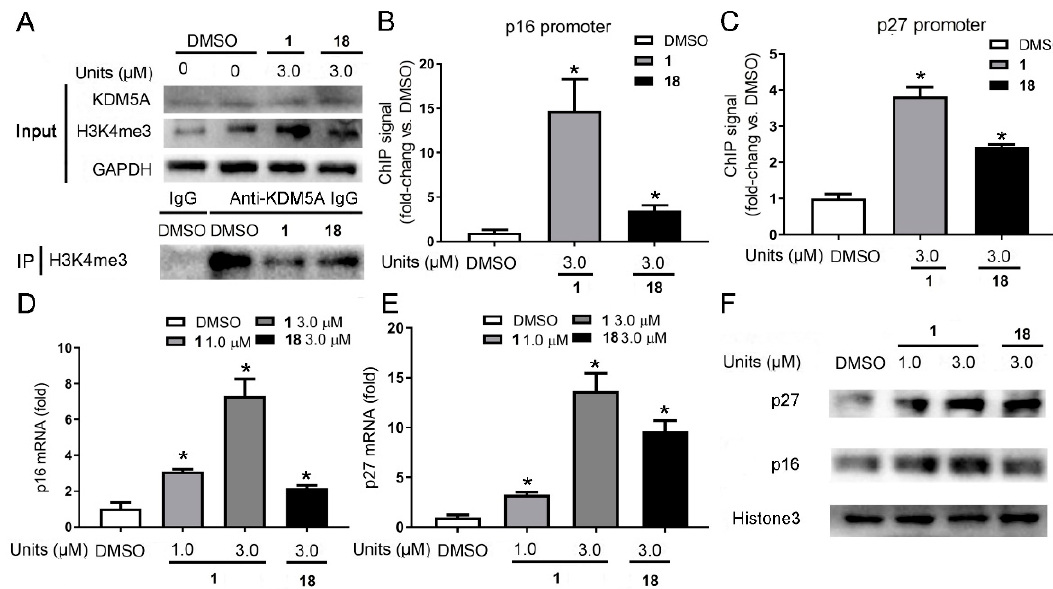
Figure 5. 1 and 18 promotes p16 and p27 production by blocking KDM5A-mediated H3K4me3 demethylation in MDA-MB-231 cells. Effect of 1 on the interactions KDM5A-H3K4me3 was examined by co-IP ( A ). Effect of 1 on H3K4me3 at promoters of p16 and p27 gene in MDA-MB-231 cells ( B , C ). ChIP assay was conducted with primary antibody against H3K4me3. transcriptional ( D , E ) and protein ( F ) levels of p21 and p27 in MDA-MB-231 cells treated with 1 or 18 were measured by Western blotting analysis. Bar graphs represented the mean enrichment relative to DMSO-treated groups and error bars reflect standard deviation of results derived from triplicate biological experiments. * p < 0.05, versus control (Student’s t -test).